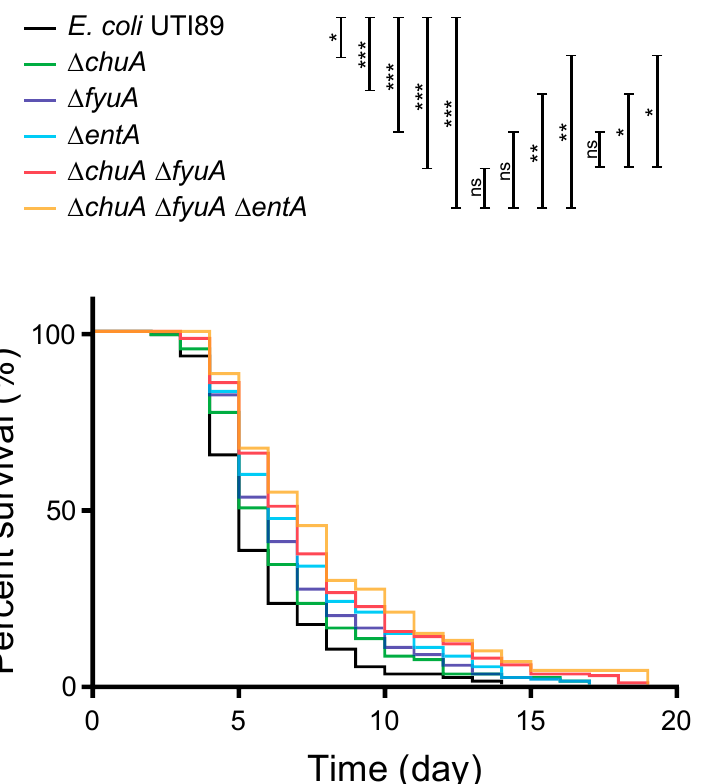
Figure 3. UPEC mutants defective in iron acquisition decreased the pathogenicity in C. elegans . The survivability of C. elegans ( n > 100) feeding on the wild type and mutants of E. coli UTI89 defective in iron acquisition, which shows association with pathogenicity in the liquid pathogenicity assay. The results were analyzed statically by the Mantel-Cox log-rank test (*, p > 0.05; **, p > 0.01; ***, p > 0.001; ns, not